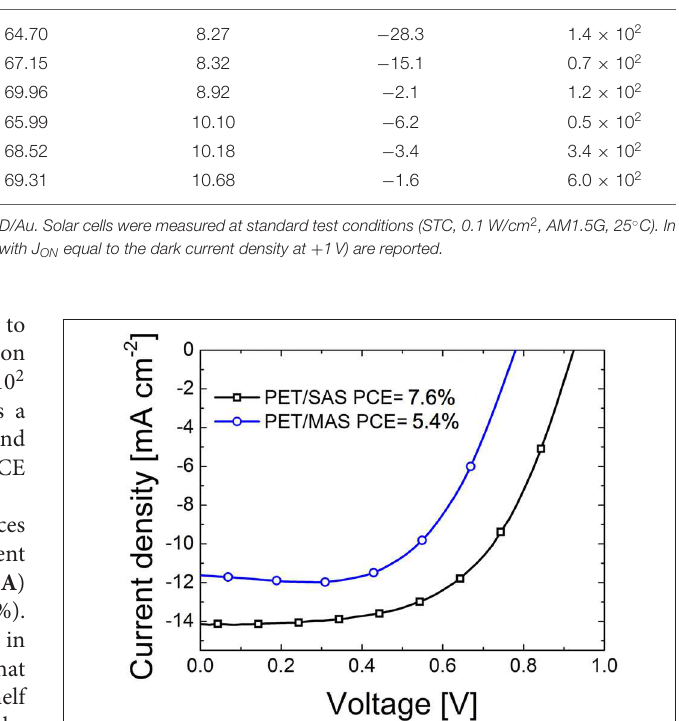
shows the J-V curves of PET/D/M/D/m-